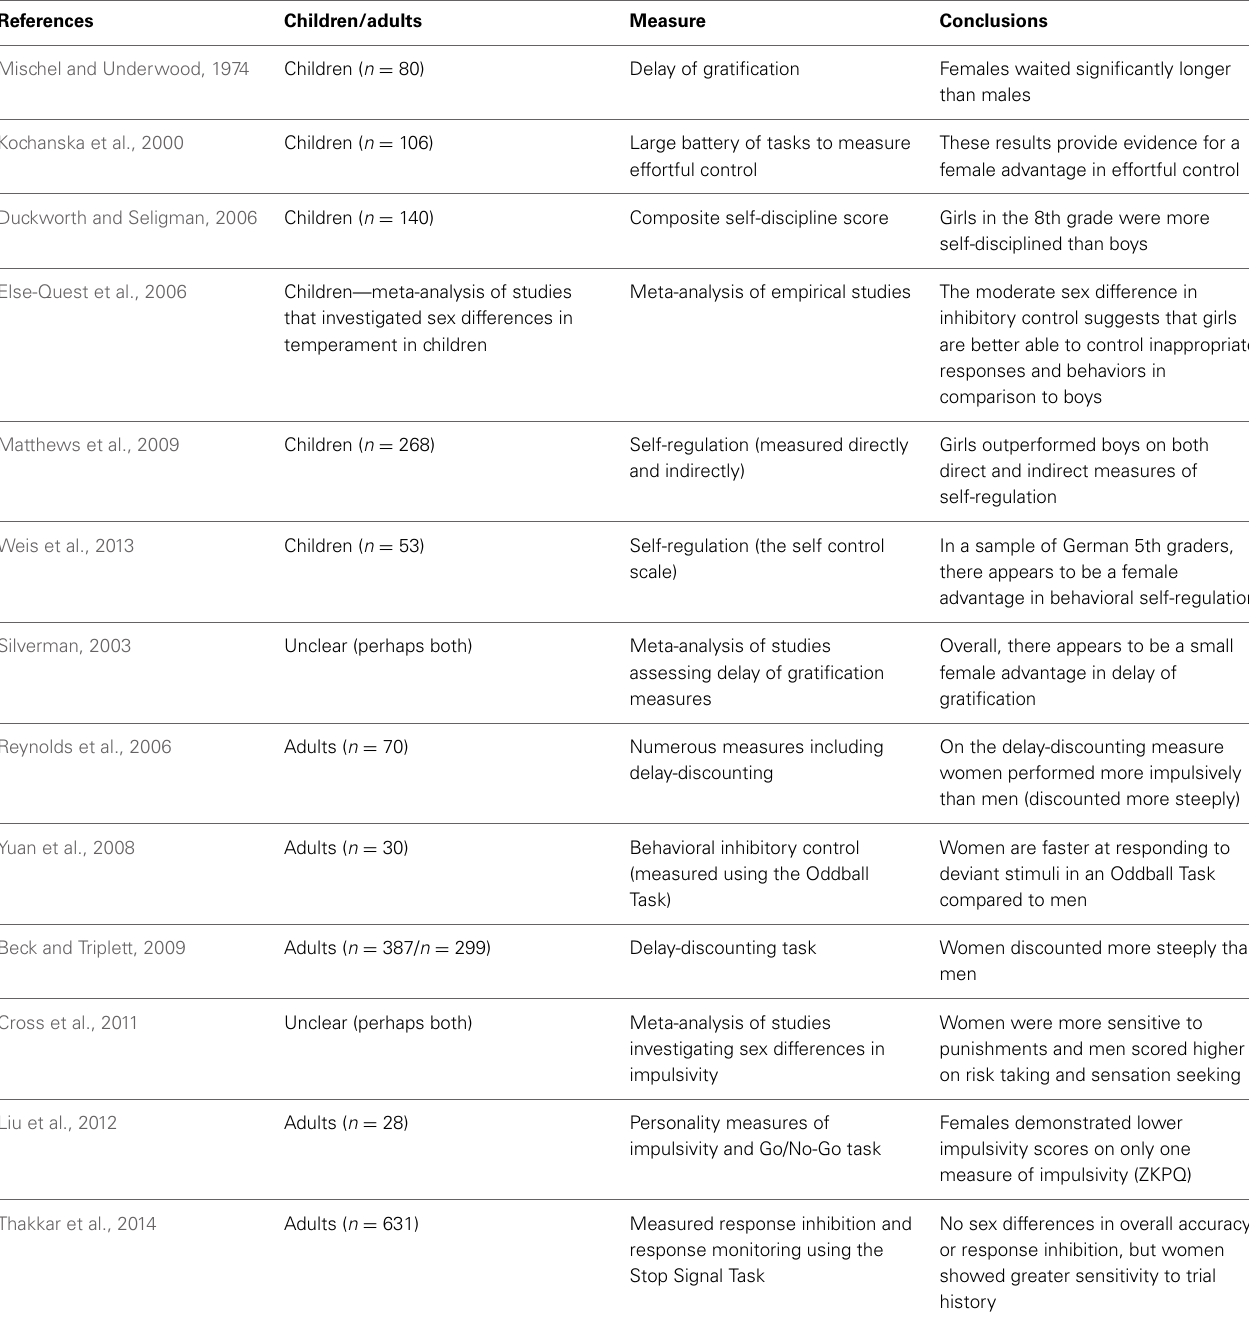
Table 2 | Sexual dimorphisms at the behavioral level: children vs.